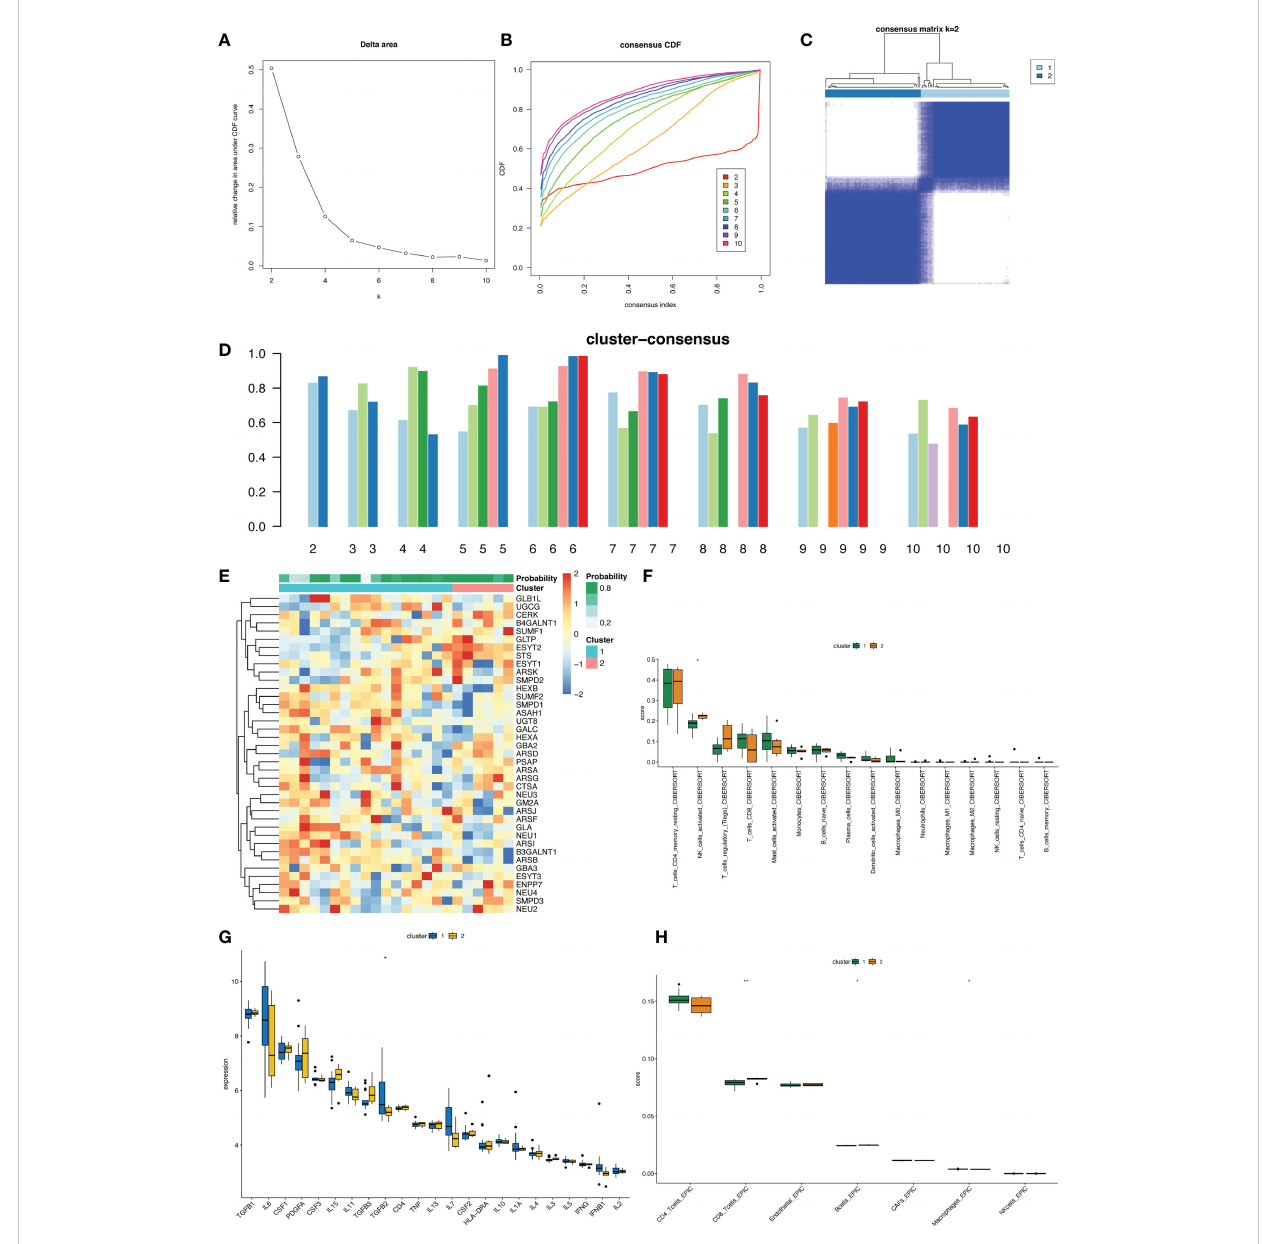
FIGURE 5 Unsupervised clustering analysis in keloid. (A) The empirical cumulative distribution function (CDF) plots revealed the consensus distributions for each k. (B) The area change under CDF curve when k=2-10. (C) The circular manhattan (CM) plot exhibited the clusters at k = 2. (D) The bar plot showed the score of each subtype for the number of clusters k from 2 to 10. (E) Heat map showing the distribution of GSLMRG expression between different clusters. (F – H) Box plots of the distribution of immune cell in fi ltration and in fl ammatory factors expression in different